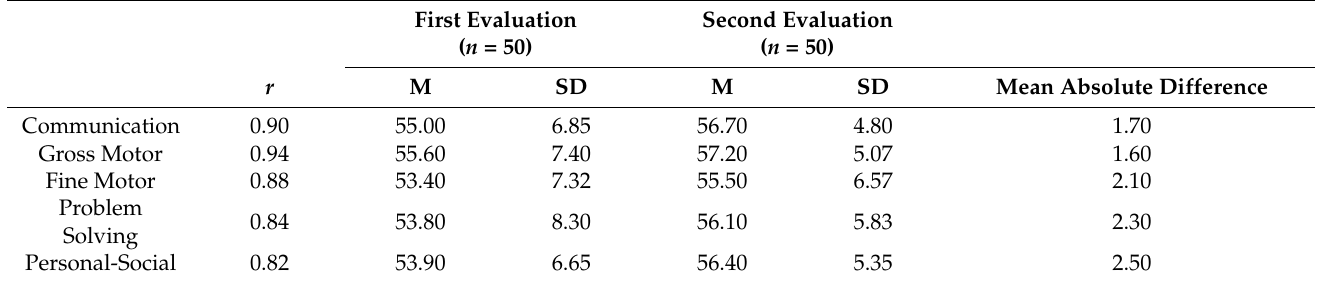
Table 4. Mean and standard deviation (raw scores) and test-retest correlation of ASQ-3 developmen- tal